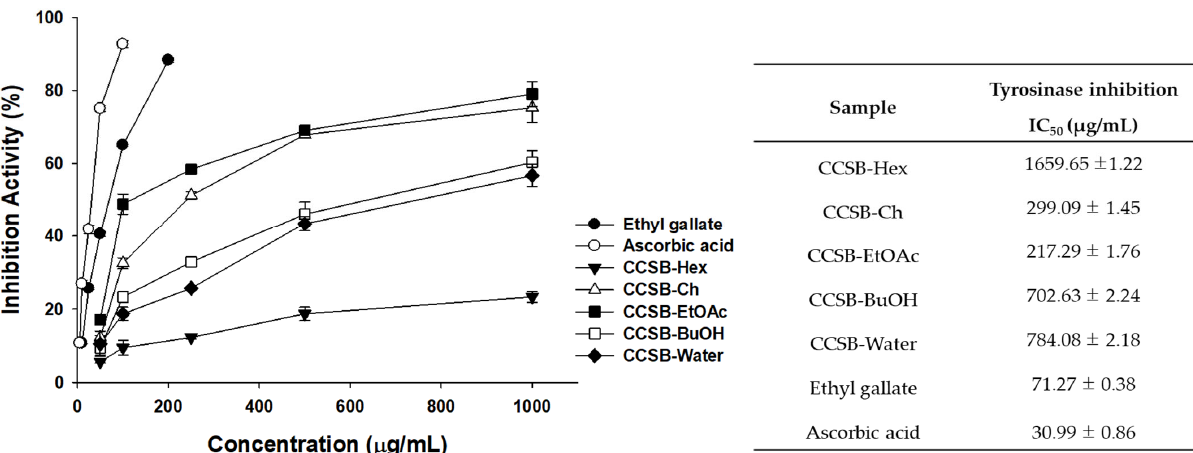
Figure 5. The IC 50 value of tyrosinase inhibition activity of the extract and solvent fractions from C. cuspidata var. sieboldii branch (CCSB). Each experiment was assayed in triplicate. Data were represented as means ± SD.